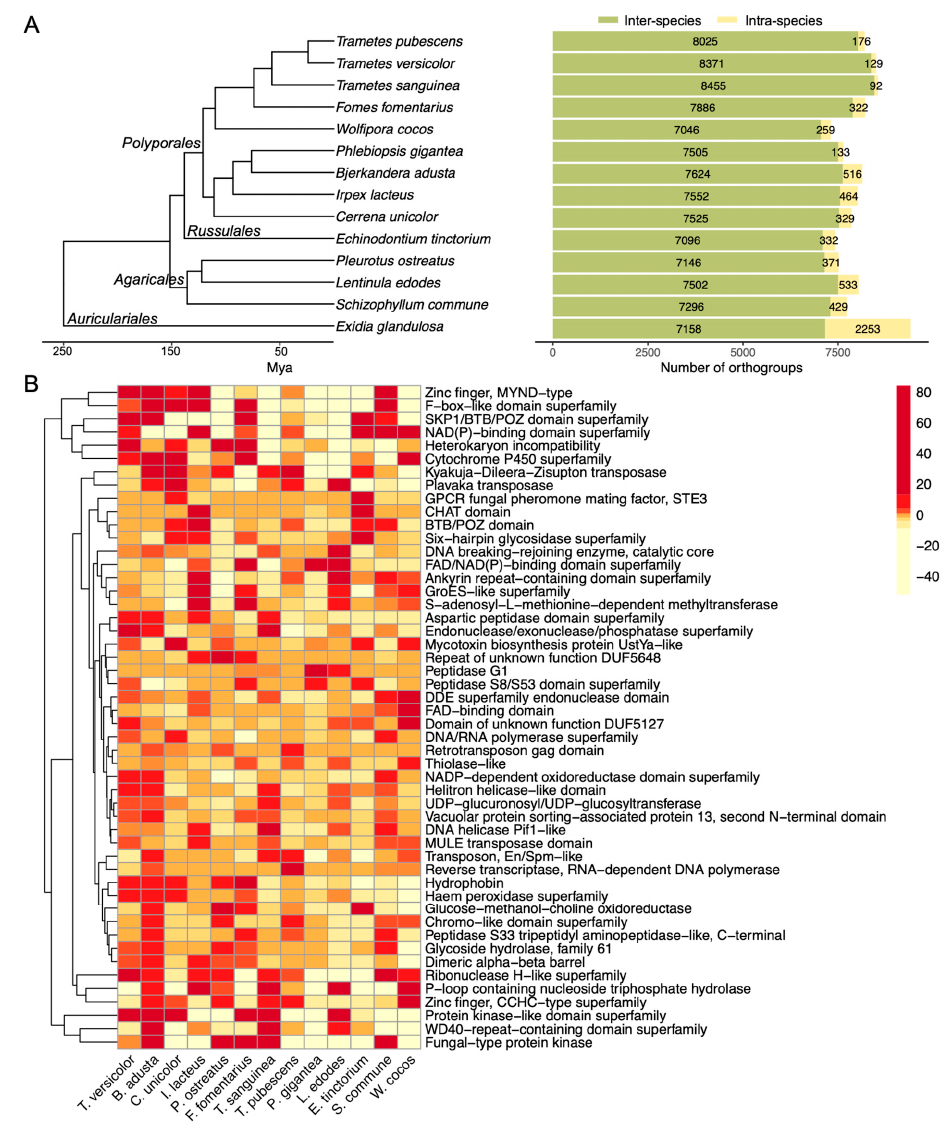
Figure 5. Gene family expansion and contraction in the selected genomes. ( A ) The phylogenetic tree and the number of gene family expansions and contractions in the selected fungal species. The number of inter-species and intra-species orthogroups identified in each genome is shown in the bar plot. Mya, million years ago. ( B ) Significant gene families underwent expansion or contraction. The color scale indicates the changes in gene family expansion or contraction for each species compared to the parent clade. Enzymes identified in the significant gene families are detailed in Table S11.